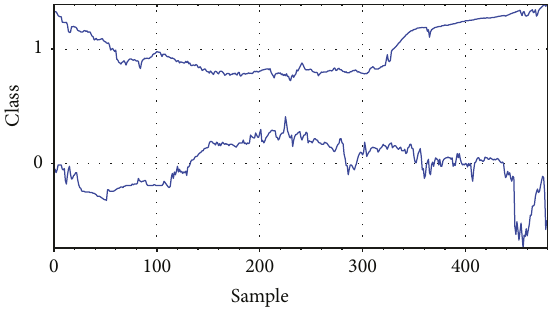
Figure 2: Example of records from each of the 2 classes of the Temp dataset.